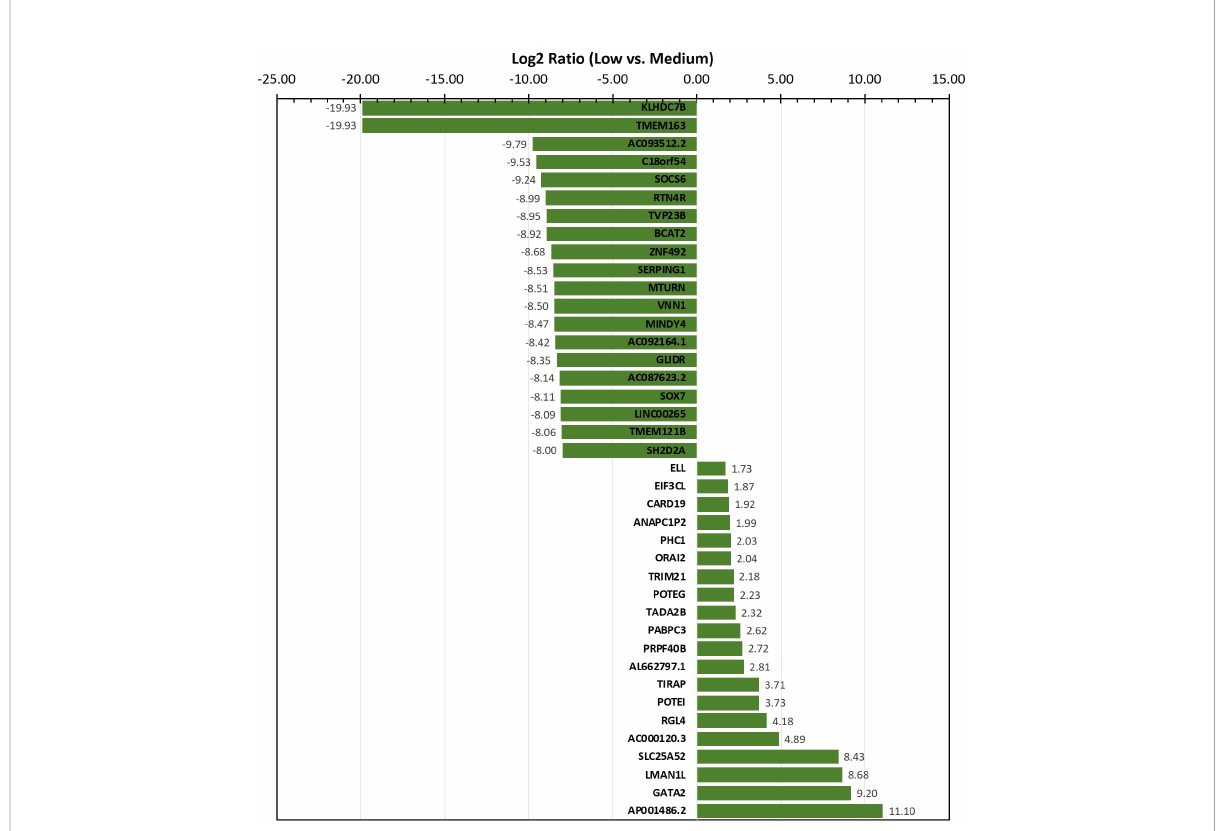
FIGURE 4 Transcripts exhibiting the highest level of differential expression in the NBDG-low population. Differentially-expressed transcripts (e.g., protein- coding genes, lncRNAs) in low glucose uptake B-ALL PDX subpopulations were identi fi ed as described above in Figure 3 and Materials and Methods. Higher stringency statistical fi ltering was imposed (FDR p<0.05). Representative, differentially-expressed transcripts exhibiting the highest magnitude log2 ratios are presented in the bar chart with the corresponding values included as data